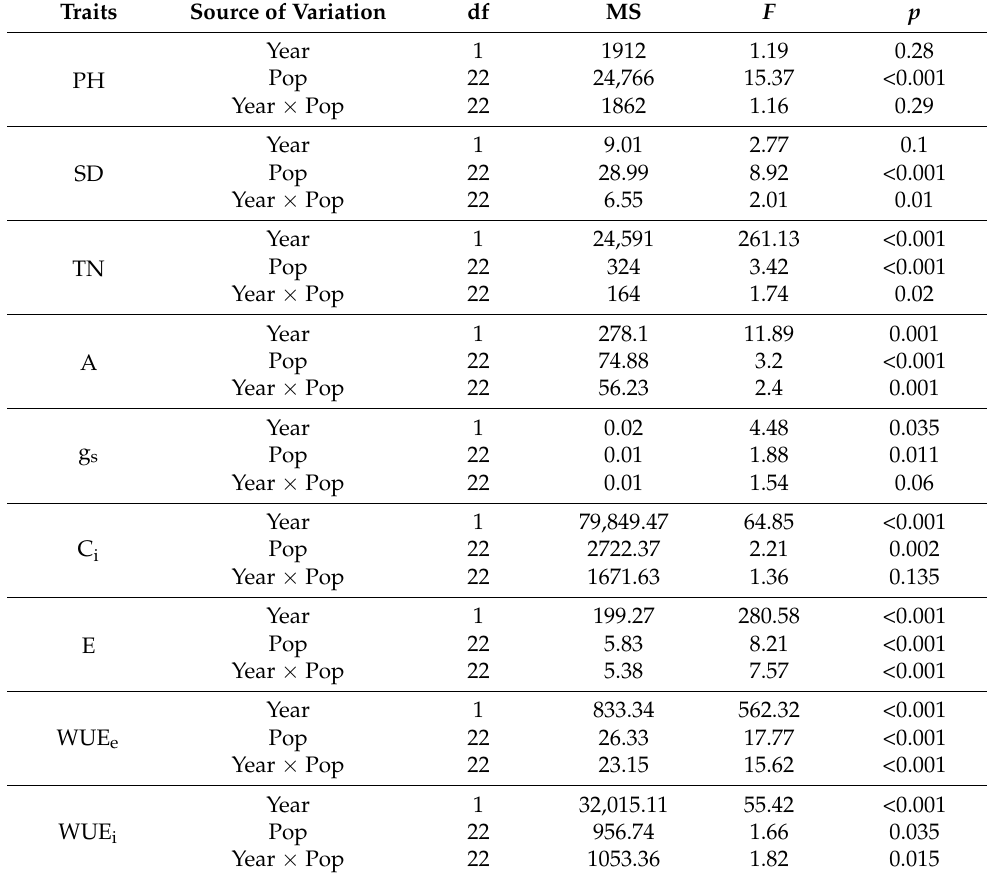
Table 1. Two-way ANOVA on growth traits and photosynthetic parameters of 155 M. lutarioriparius individuals in the arid Huanxian of the Gansu (HG). Year: growing seasons; Pop: populations. PH: plant height; SD: stem diameter; TN: tiller number; A: photosynthetic rate; E: transpiration rate; g s : stomatal conductance; C i : intercellular CO 2 concentration; WUE e : extrinsic water use efficiency; WUE i : intrinsic water use efficiency. MS: Mean